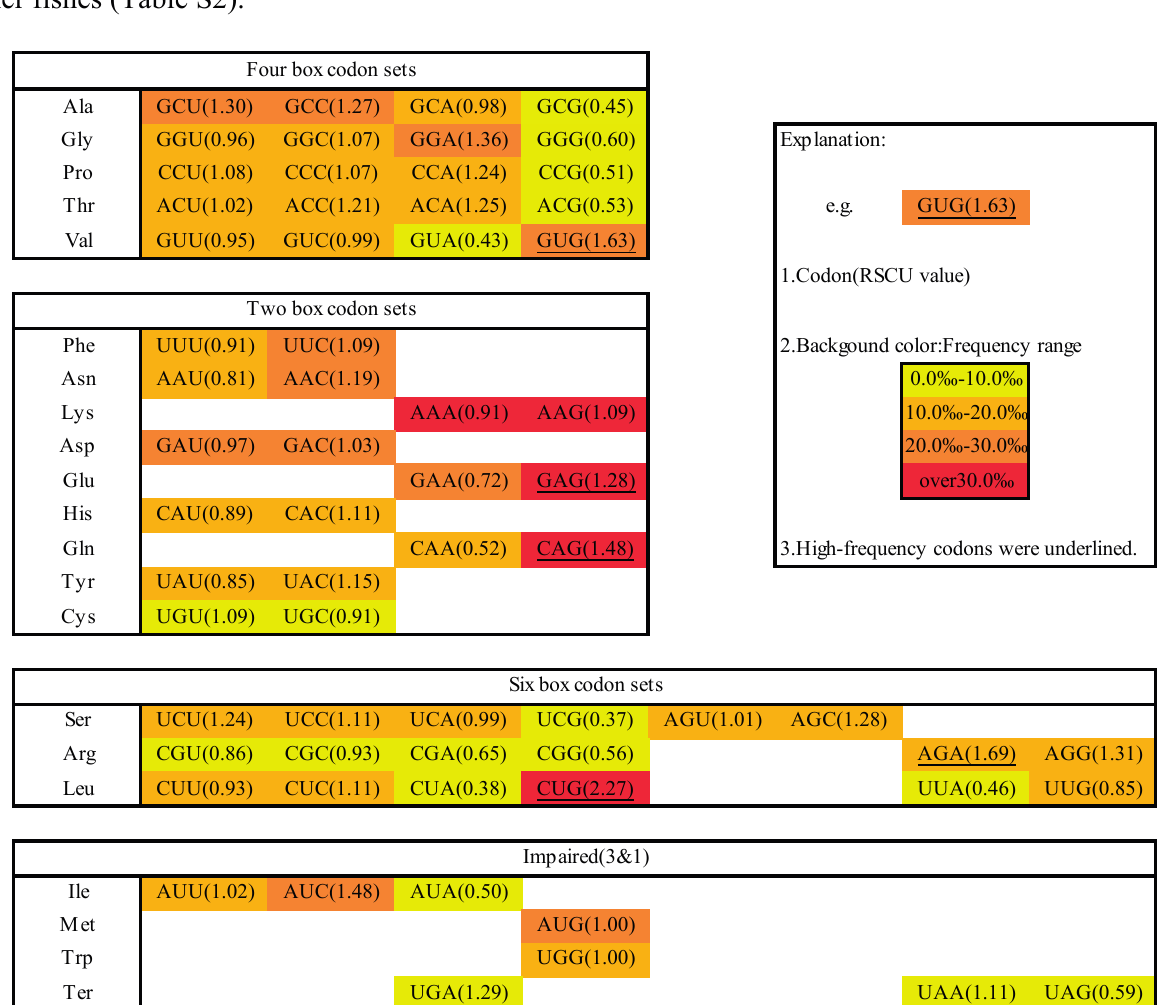
Figure 1. Unequal usage of 64 codons in M. amblycephala . The codons for the same amino acids are listed on the left and are colored yellow, orange yellow, orange and red to show occurrence frequencies of 0.0‰–10.0‰, 10.0‰–20.0‰, 20.0‰–30.0‰, and over 30.0‰, respectively. The data is shown as a triplet codon (RSCU, relative synonymous codon usage), and high-frequency codons are